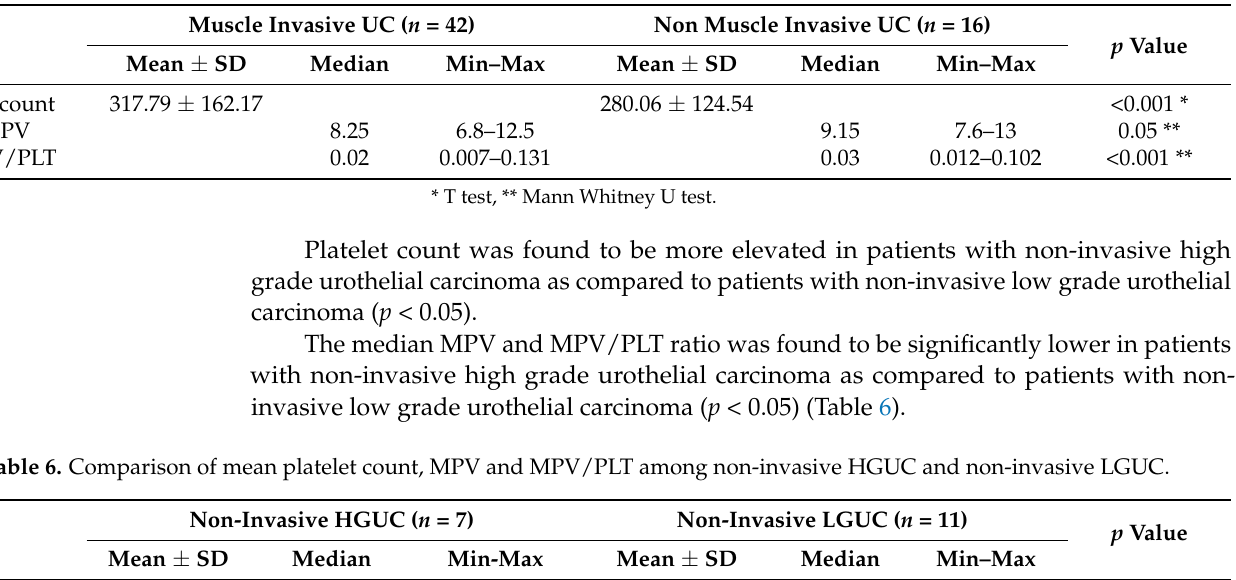
Table 5. Comparison of mean platelet count, MPV and MPV/PLT among muscle invasive urothelial carcinoma and non-muscle invasive urothelial carcinoma.